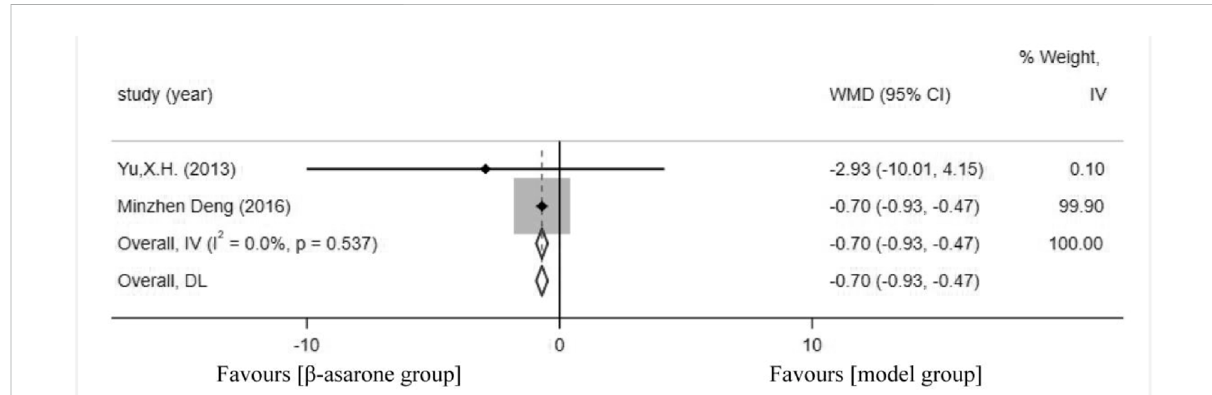
FIGURE 8 Forest plot for comparison: β -asarone group versus model group. Outcome: the signal pathway-related proteins PI3K/AKT.